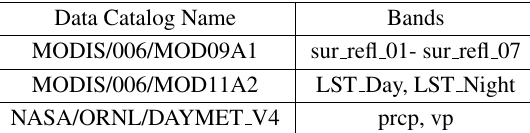
Table 2. Data catalog names and the bands utilized.